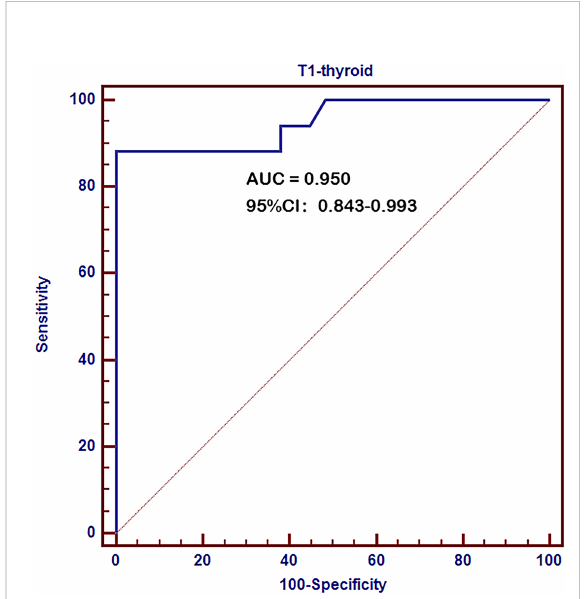
FIGURE 1 Receiver operating characteristic (ROC) curves of thyroid T1- mapping values for pathological diagnosed AIT. The area under the curve (AUC) was 0.950 (95%CI: 0.843 – 0.993, P < 0.001). The optimal cutoff point estimated from Youden index was 997, with a sensitivity of 88.2% and a speci fi city of 100.0%.